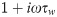
Regimes of the current-to-voltage transfer function.(a) Phase diagram of the transfer function. The region of depolarizing w (low frequency amplifying, V
low > 1) is shown in purple and voltage resonance in green. The filter is unstable in the blue region. An intrinsic frequency exists above the dotted line, Q
L = 1/2. Note that there is a region with Q
L > 1/2 and no voltage resonance, and vice versa. The star and circle denote the example values of (ω
Lτw, Q
L) used in (b) and (c), respectively. (b) An example of the current-to-voltage filter in the case of resonance with no intrinsic frequency (τV = 10, τw = 100, g = 1.2). (c) An example of the current-to-voltage filter in the case of no voltage resonance despite the existence of an intrinsic frequency (τV = 10, τw = 5, g = 0.5). The rising and falling dashed lines in (b) and (c) denote the contributions of the high pass, 1+iωτw, and the low pass, (1−ω2/ωL2+iω/QLωL)−1, respectively. Their combination forms the current-to-voltage filter, which are shown as solid lines.